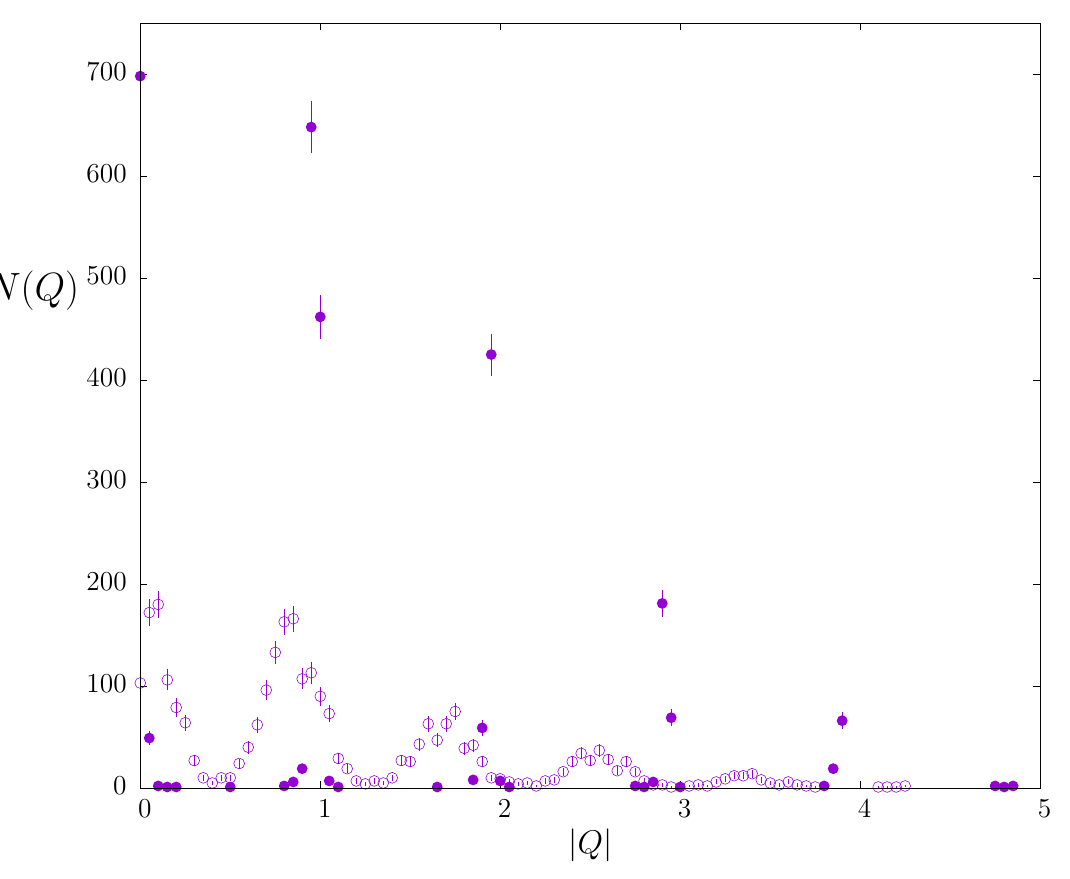
Figure 28 . Histogram of lattice Q on fields after 2 cooling sweeps, ◦ , and after 20 cooling sweeps, • . From 2500 measurements at β = 6 . 50 on a 26 3 38 lattice. Points corresponding to N ( Q ) = 0 are